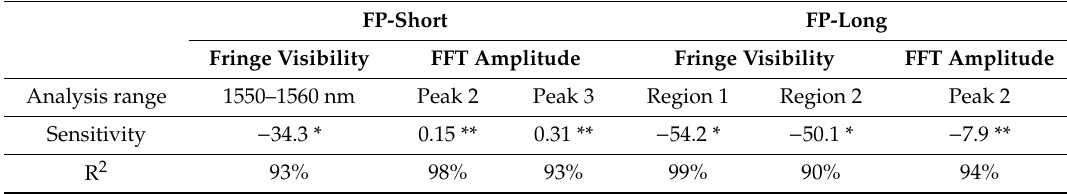
Table 2. Results of the sensitivity analysis. Values are approximated.